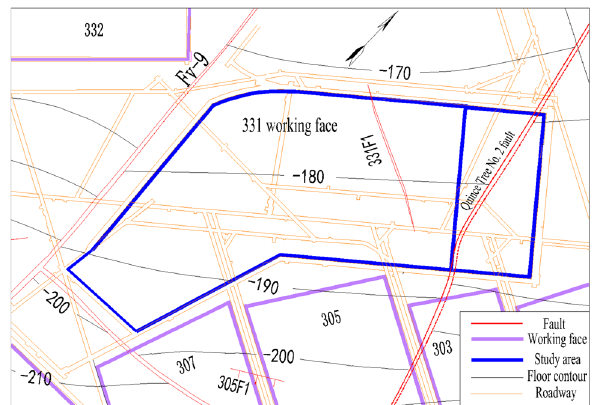
Figure 2. 331 working face of Yangcun Coal